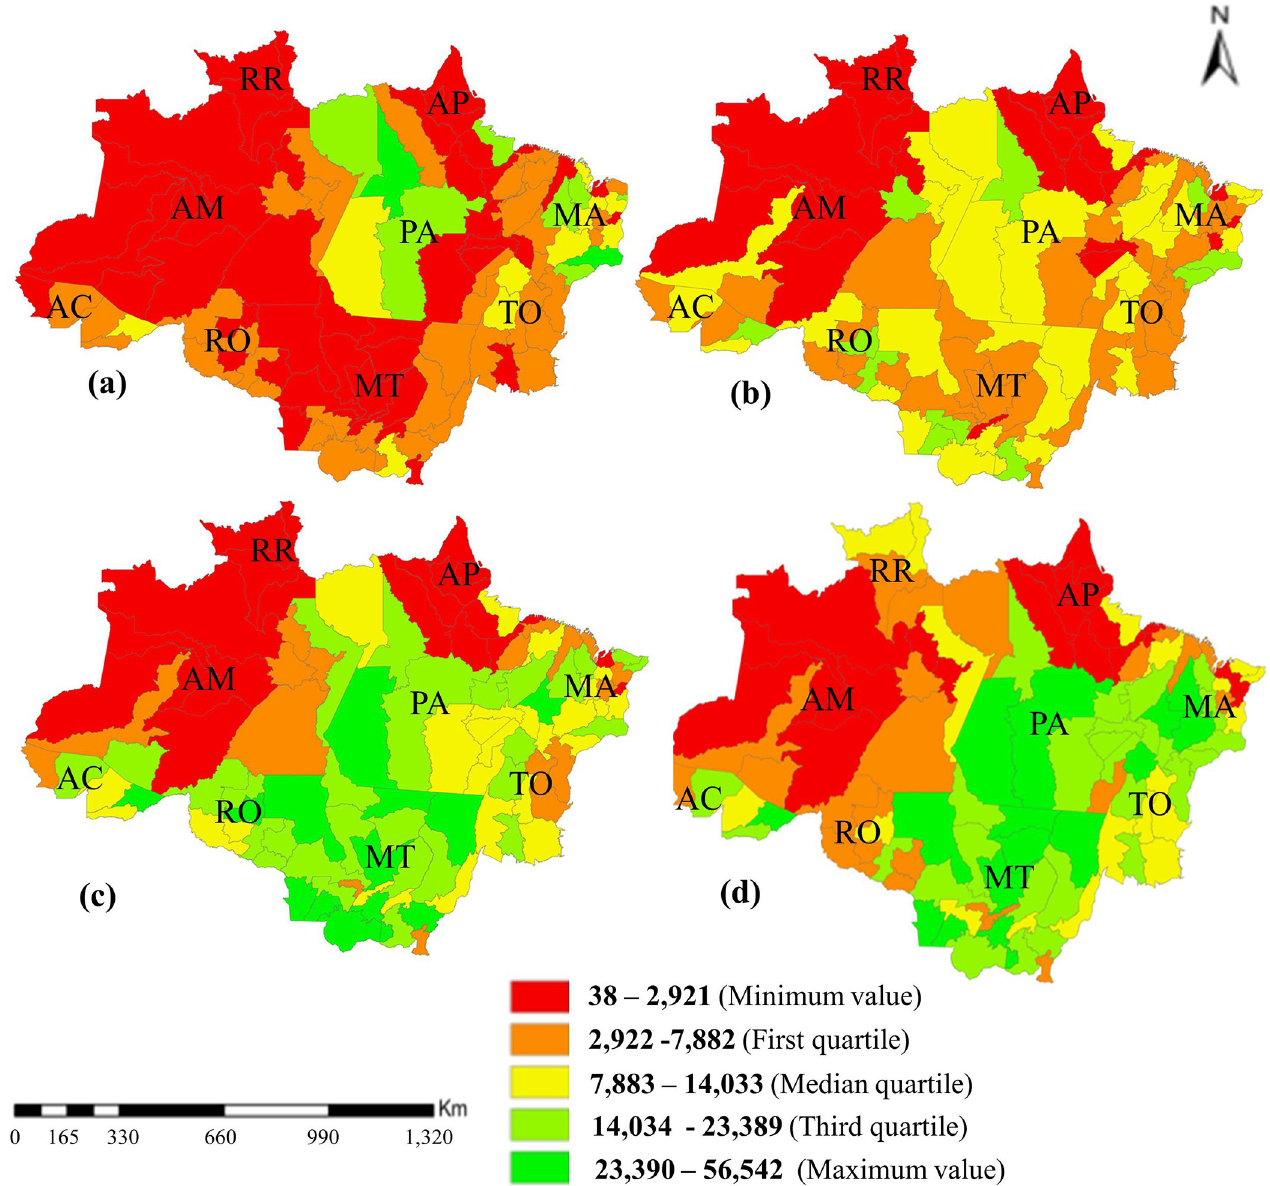
Fig 1. Sheep herd distribution in the Legal Amazon (a.1990, b.2000, c.2010, d.2020). RO, Rondoˆnia; AC, Acre; AM, Amazonas; RR, Roraima; PA, Para´; AP, Amapa´; TO, Tocantins; MA, Maranh ã o; MT, Mato Grosso.